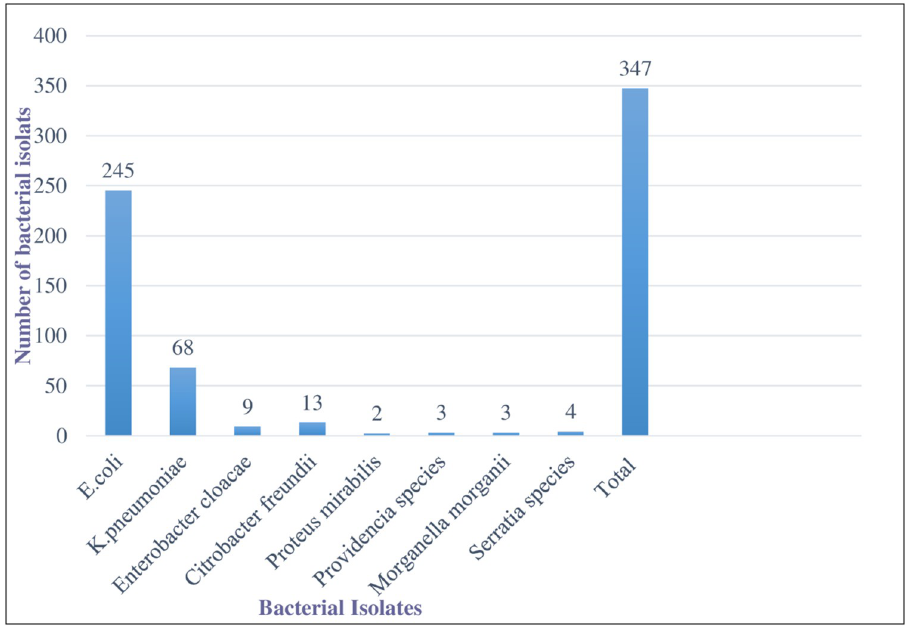
Fig 1. Prevalence of Enterobacteriaceae isolates from stool sample at University of Gondar Comprehensive Specialized Hospital and students’ cafeteria, February to June 2021.